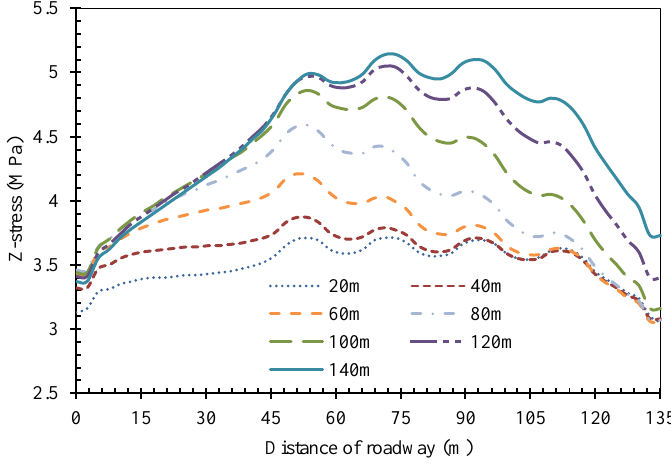
Figure 16. Stress evolution of materials haulage roadway during mining distances.